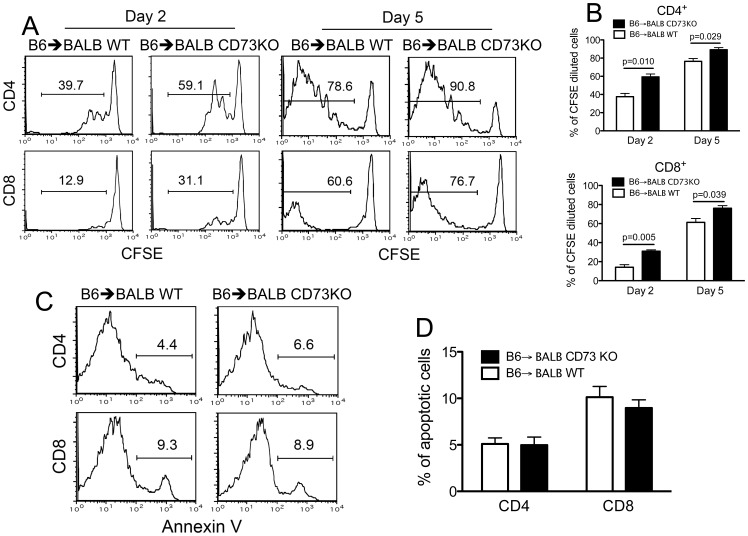
Enhanced proliferation but normal survival of allogeneic donor T cells in CD73 KO recipients.(A) Sublethally irradiated WT or CD73 KO BALB/c mice were given i.v. injections of 2×107 dye (CFSE)-labeled splenocytes from WT B6 donors. Division of host-reactive donor T cells was measured 2 and 5 days after cell transfer. CFSE intensity was gated on H-2Kd-negative (donor) CD4+ or CD8+ T cells. The percentage of donor T cells with more than one division is indicated in each panel and summarized in (B). (C) Annexin V staining of donor cells gated on H-2Kd-negative CD4+ or CD8+ T cells 5 days after cell transfer. The percentage of apoptotic donor T cells (annexin V+) is indicated in each panel (C) and summarized in (D). Data are given as means ± SEM. Results are representative of 3 independently performed experiments with similar results.